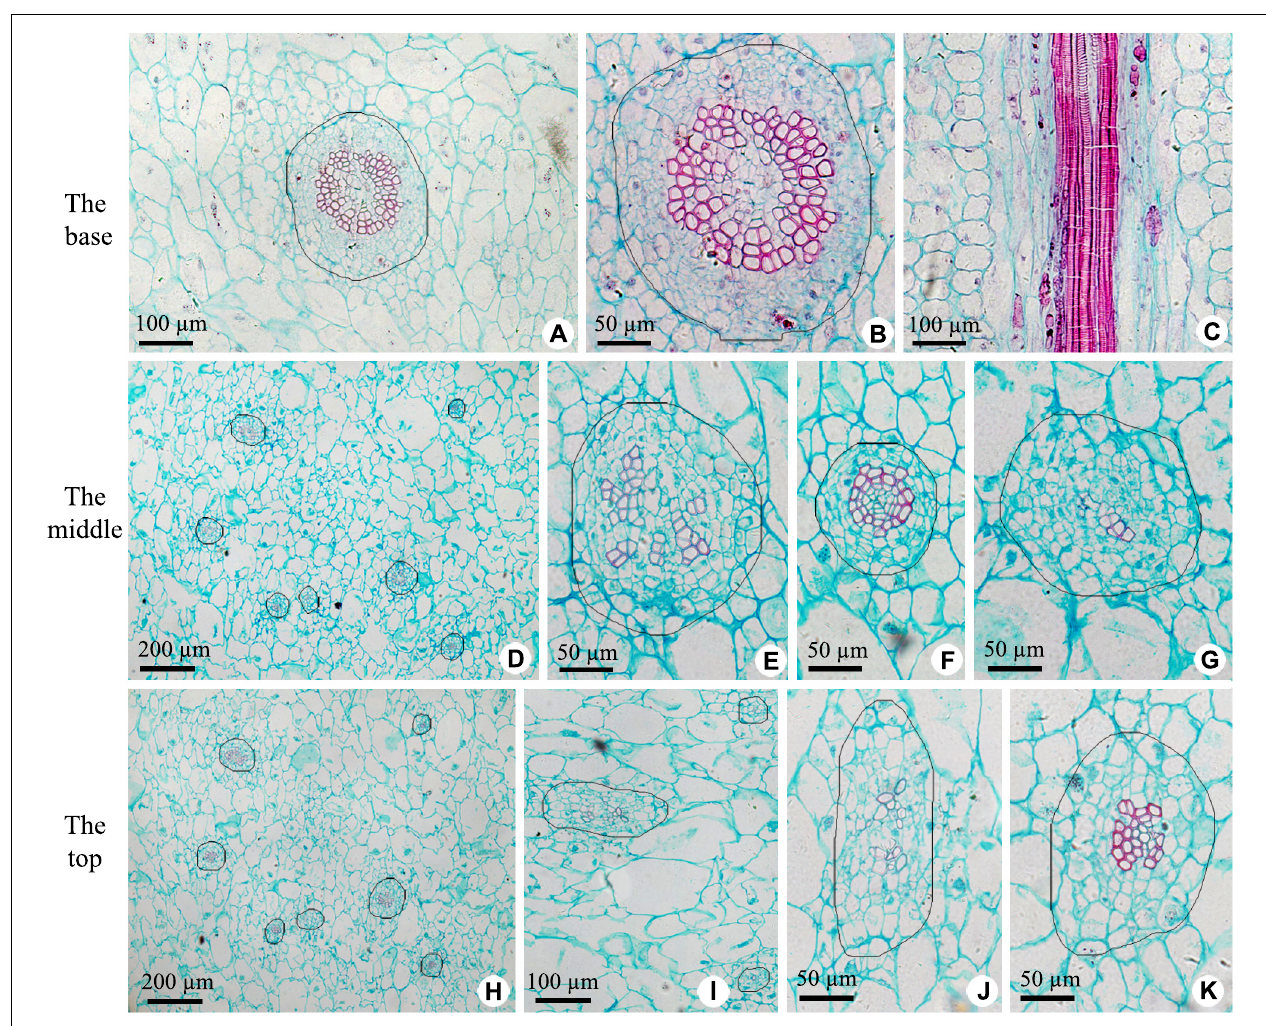
FIGURE 2 | Sections of central placenta at the base, in the middle and near the top of fruits, respectively. (A–C) Views at the base. (A) Cross section of central placenta, showing one of vascular bundles. (B) Detailed view in Figure 2A , showing an amphicribral vascular bundle with the phloem surrounding the xylem. (C) Longitudinal section of central placenta, showing annular tracheids in xylem of amphicribral vascular bundle. (D–G) Views in the middle. (D) Cross section of central placenta, showing seven vascular bundles. (E) Detailed view of one of the amphicribral vascular bundles, showing the phloem surrounding the xylem, which is divided into several segments by parenchyma.